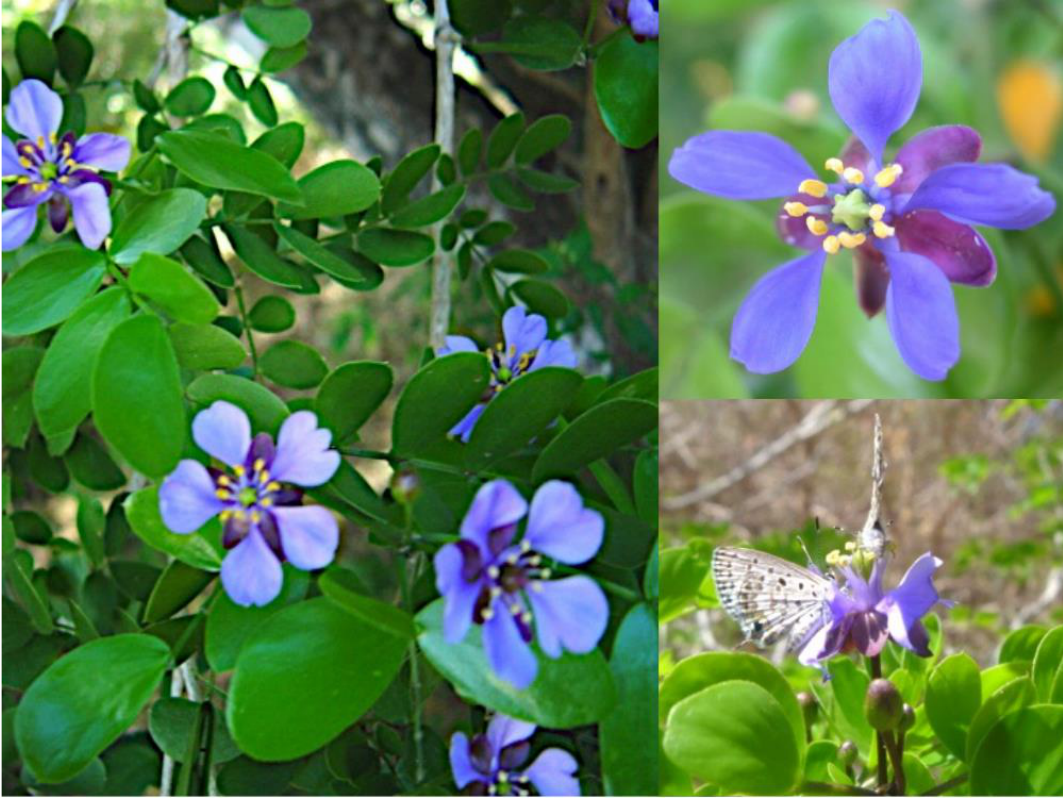
Figure 2. Flowers, details of reproductive structures, and visitors of Guaiacum sanctum